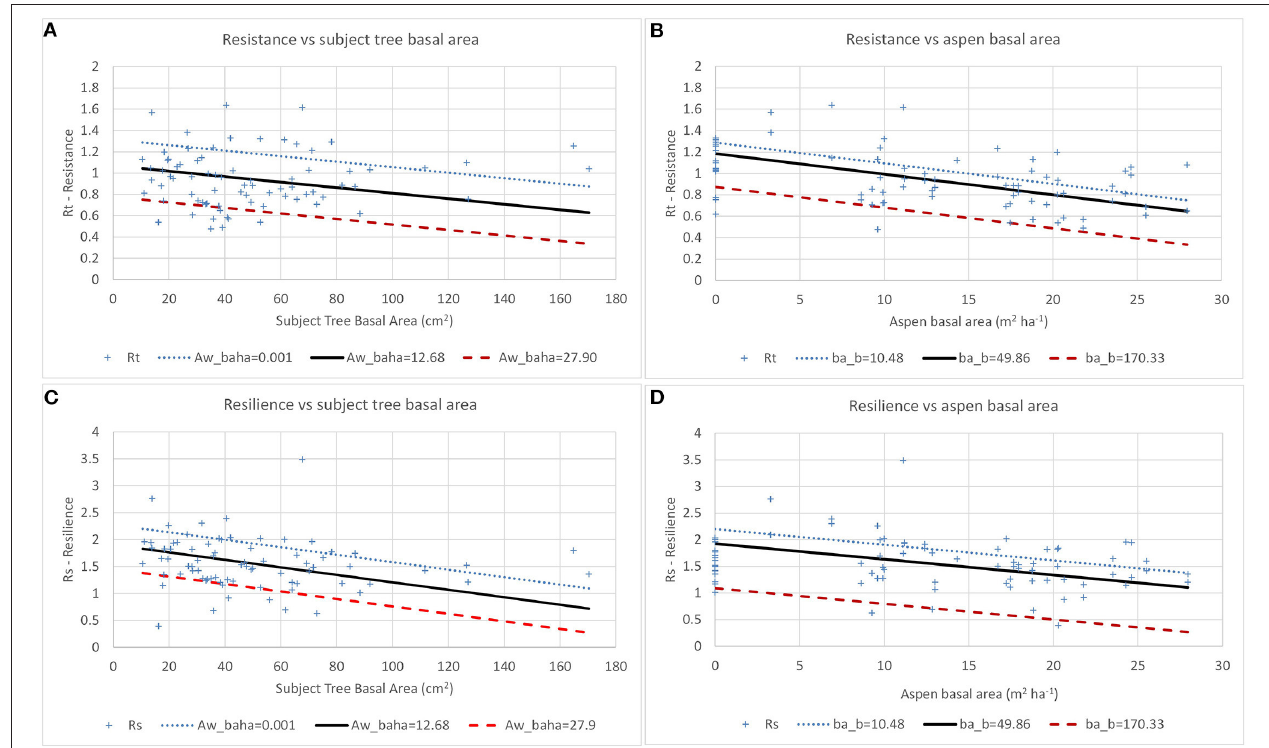
FIGURE 7 | Effects of tree size (A,C) and aspen basal area (B,D) on white spruce resistance (Rt) and resilience (Rs) in 2013. Aw_baha = aspen basal area (m 2 ha − 1 ) and ba_b = initial tree size (m 2 ).